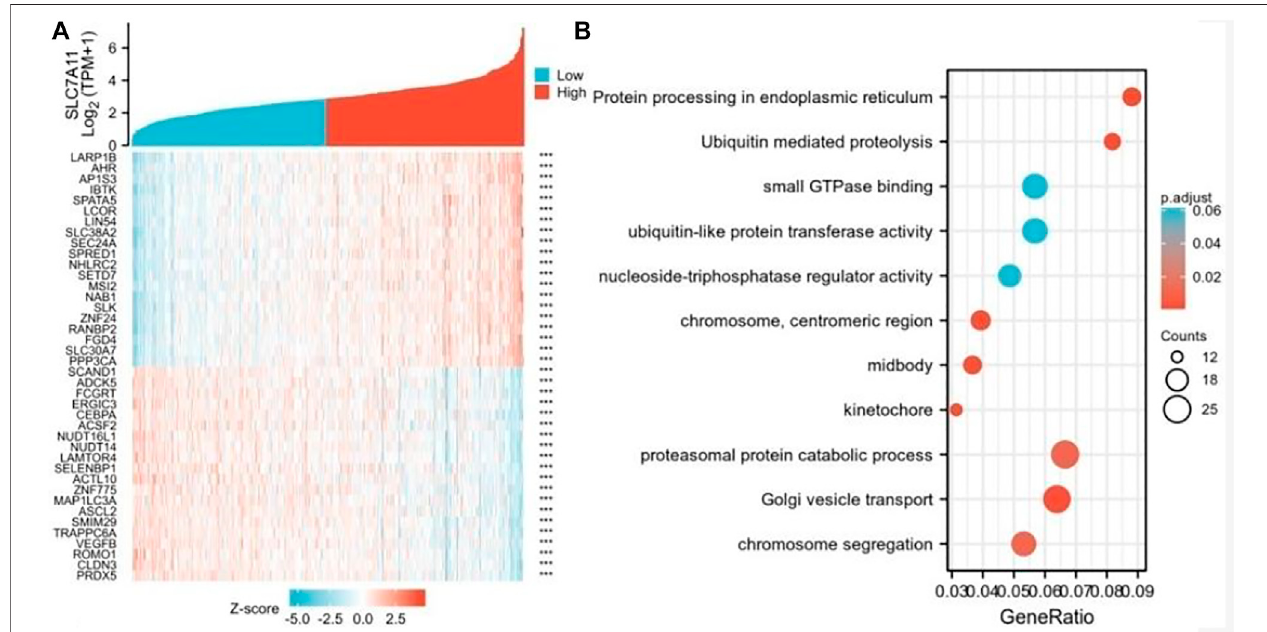
FIGURE4| GenesanalysisofcloselyassociatedwithSLC7A11inCOAD. (A) Thetop50genescorrelatedwithSLC7A11inCOADareshowedintheheatmap;*** p < 0.01. (B) GO – KEGG enrichment analysis of co-expression genes with SLC7A11 in COAD.